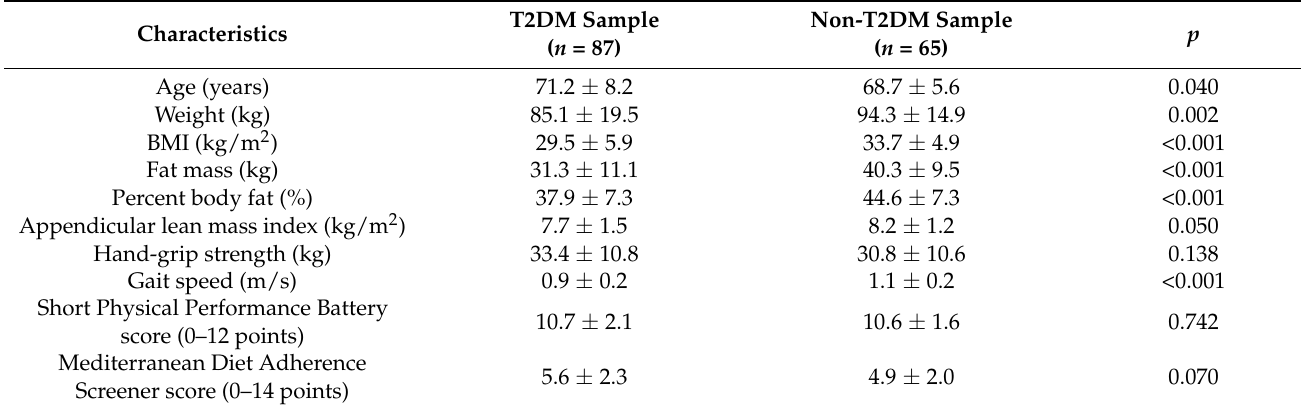
Table 1. Participant characteristics according to the two separate (T2DM sample vs. non-T2DM sample) study groups of middle-aged and older